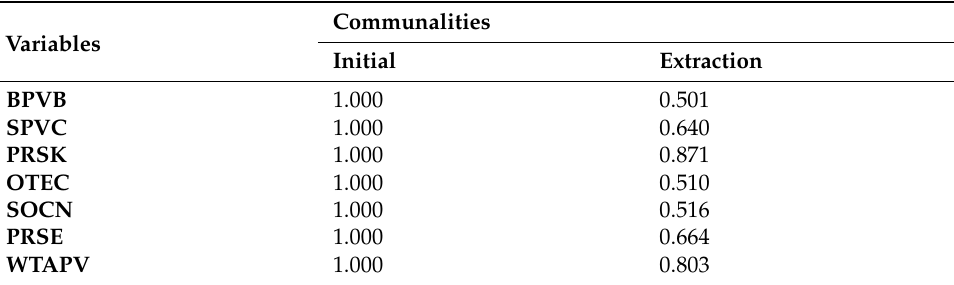
Table 10. Communalities findings.